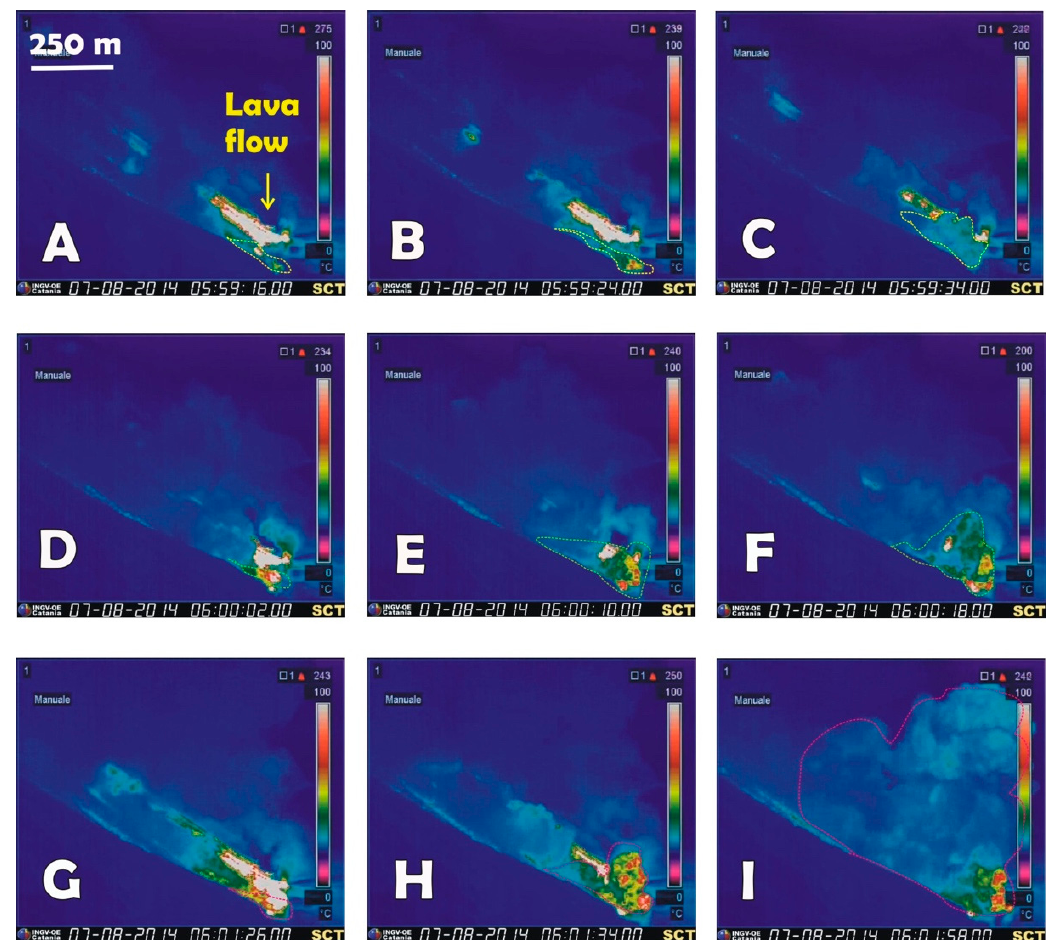
Figure 8. Lava flows (white) and hot avalanches (yellow, green, and purple dotted outline) spreading along the lower slope of Sciara del Fuoco and to the sea, as observed by the thermal images recorded by the SCT camera located at Labronzo, ~100 m a.s.l. on the east side of the Sciara on 7 August 2014. See Figure 1b for camera location. ( A – C ): lava flow spreading to the coast, flanked by a hot avalanche (yellow dotted outline) at 5:59; ( D – F ): another hot avalanche spreading at 6:00 (yellow dotted line); ( G – I ): a much bigger hot avalanche spreading at 6:01 (red dotted outline) forming a conspicuous dust cloud).